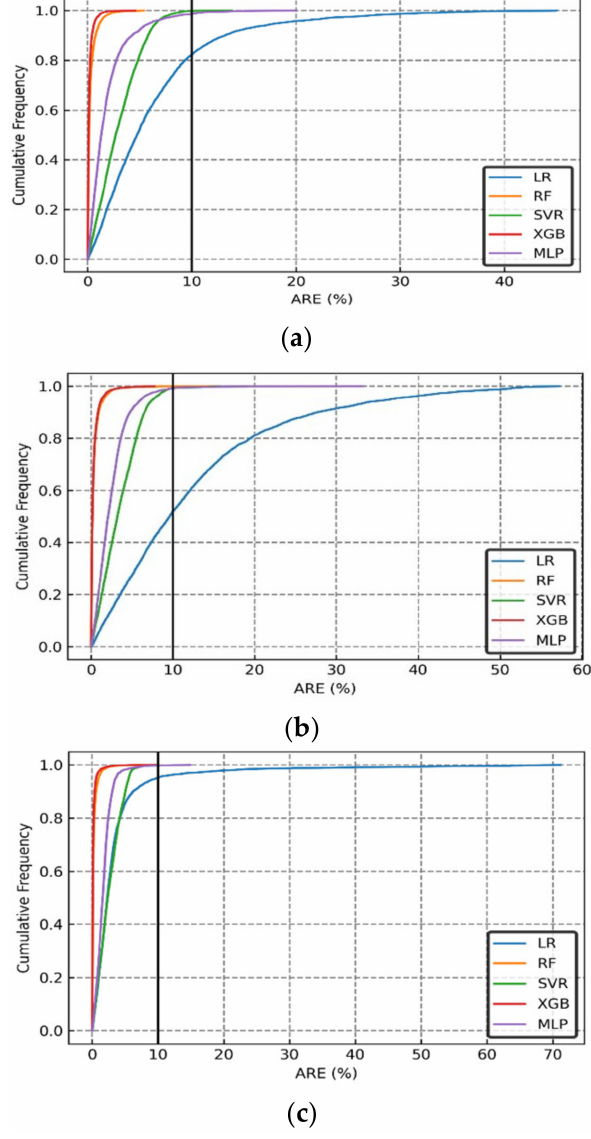
Figure 15. Cumulative frequency of Absolute Relative Error (ARE) of ( a ) CO 2 Dissolved, ( b ) CO 2 Trapped, and ( c ) CO 2 Mineralized predicted using the various ML-based